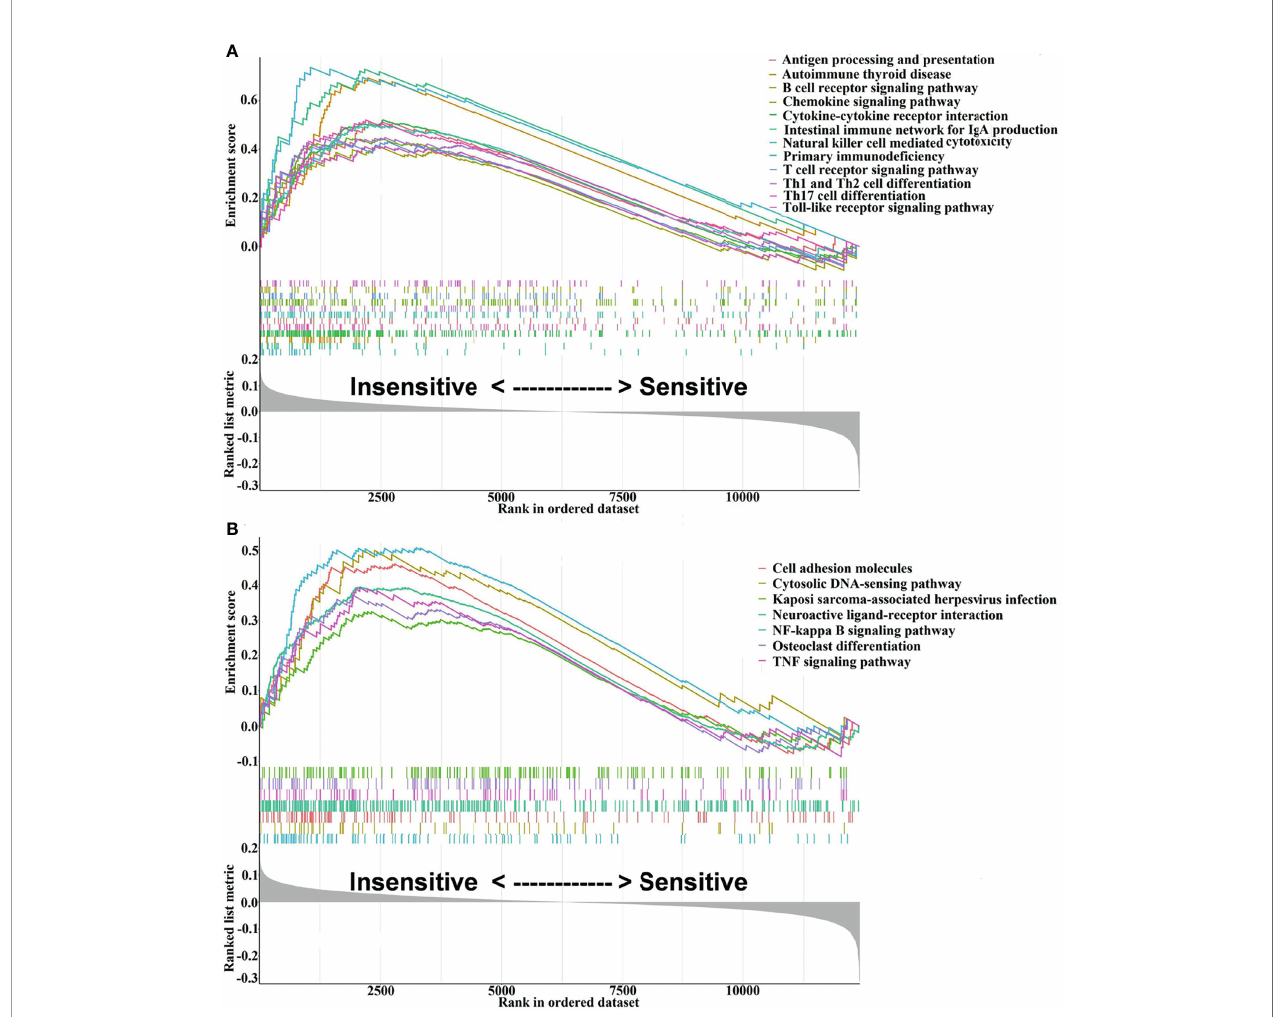
FIGURE 2 | Visualization of the interesting results, including 12 immune-related and 7 tumor-related signaling pathways, was performed using the enrichplot package. (A) The top 12 immune-related signaling pathways. (B) The top 7 tumor-related signaling